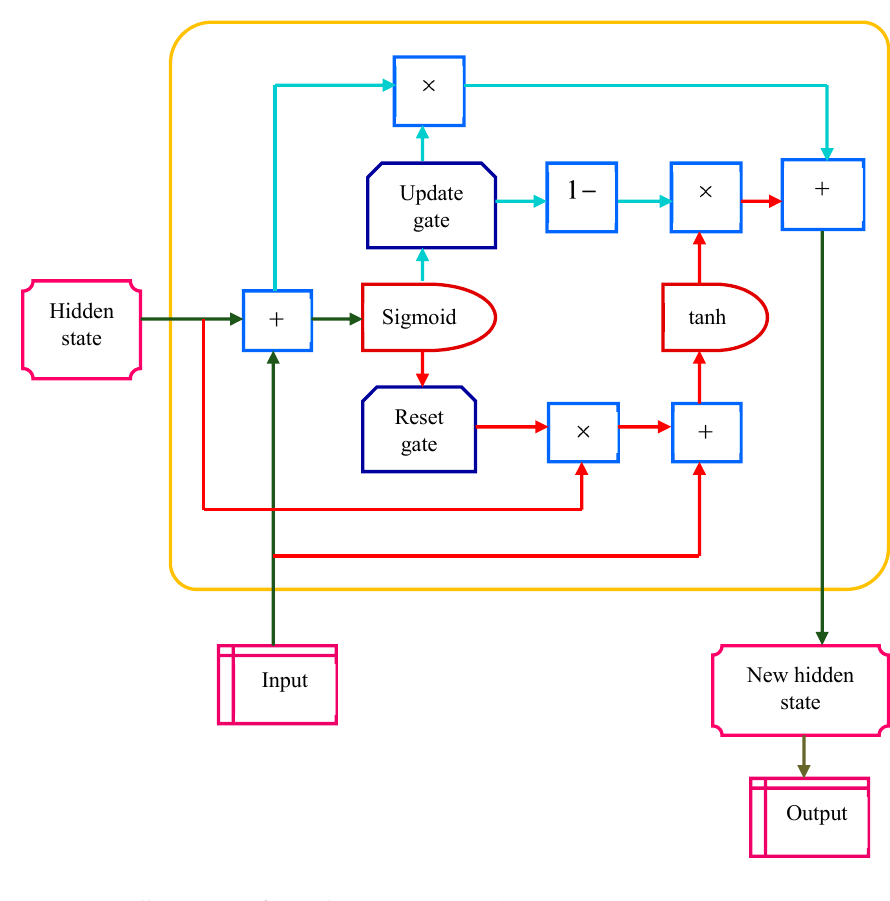
Figure 2. An illustration of Gated Recurrent Unit